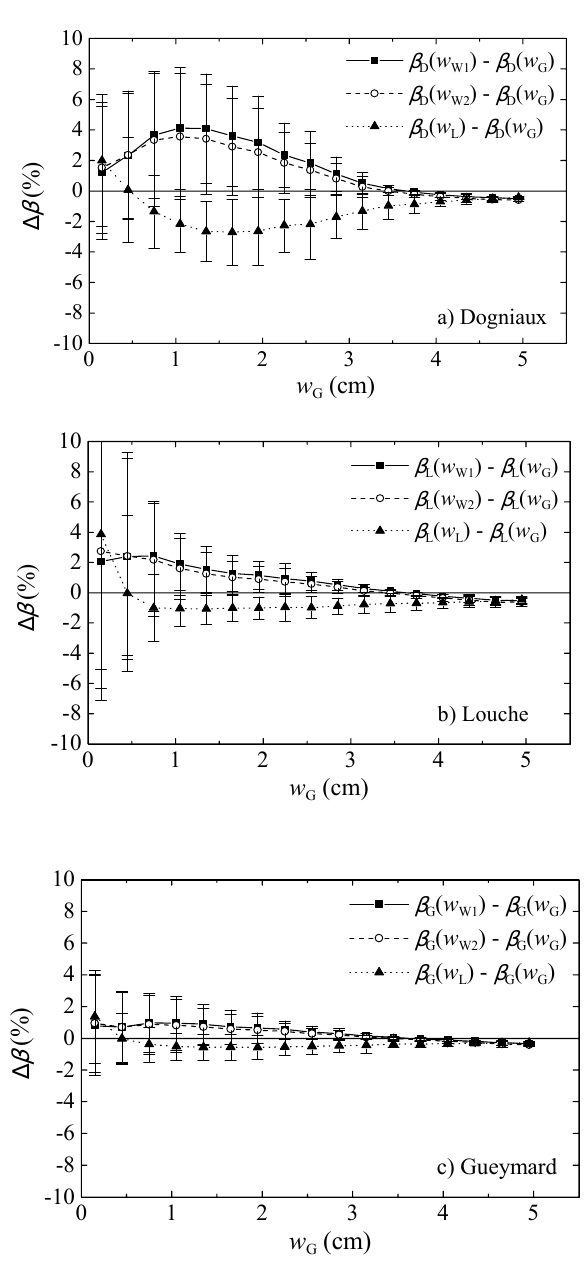
Fig. 2. Average relative differences (as legends inside of the fig- ures refer to) against precipitable water calculated by Gueymard’s method for each turbidity